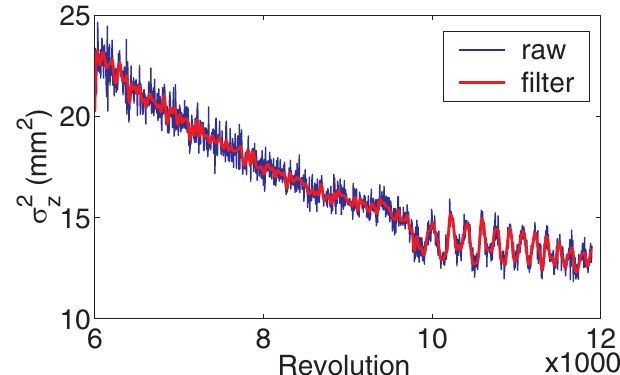
FIG. 6. (Color) The raw (blue) and filtered (cid:2) 2 injection are shown for